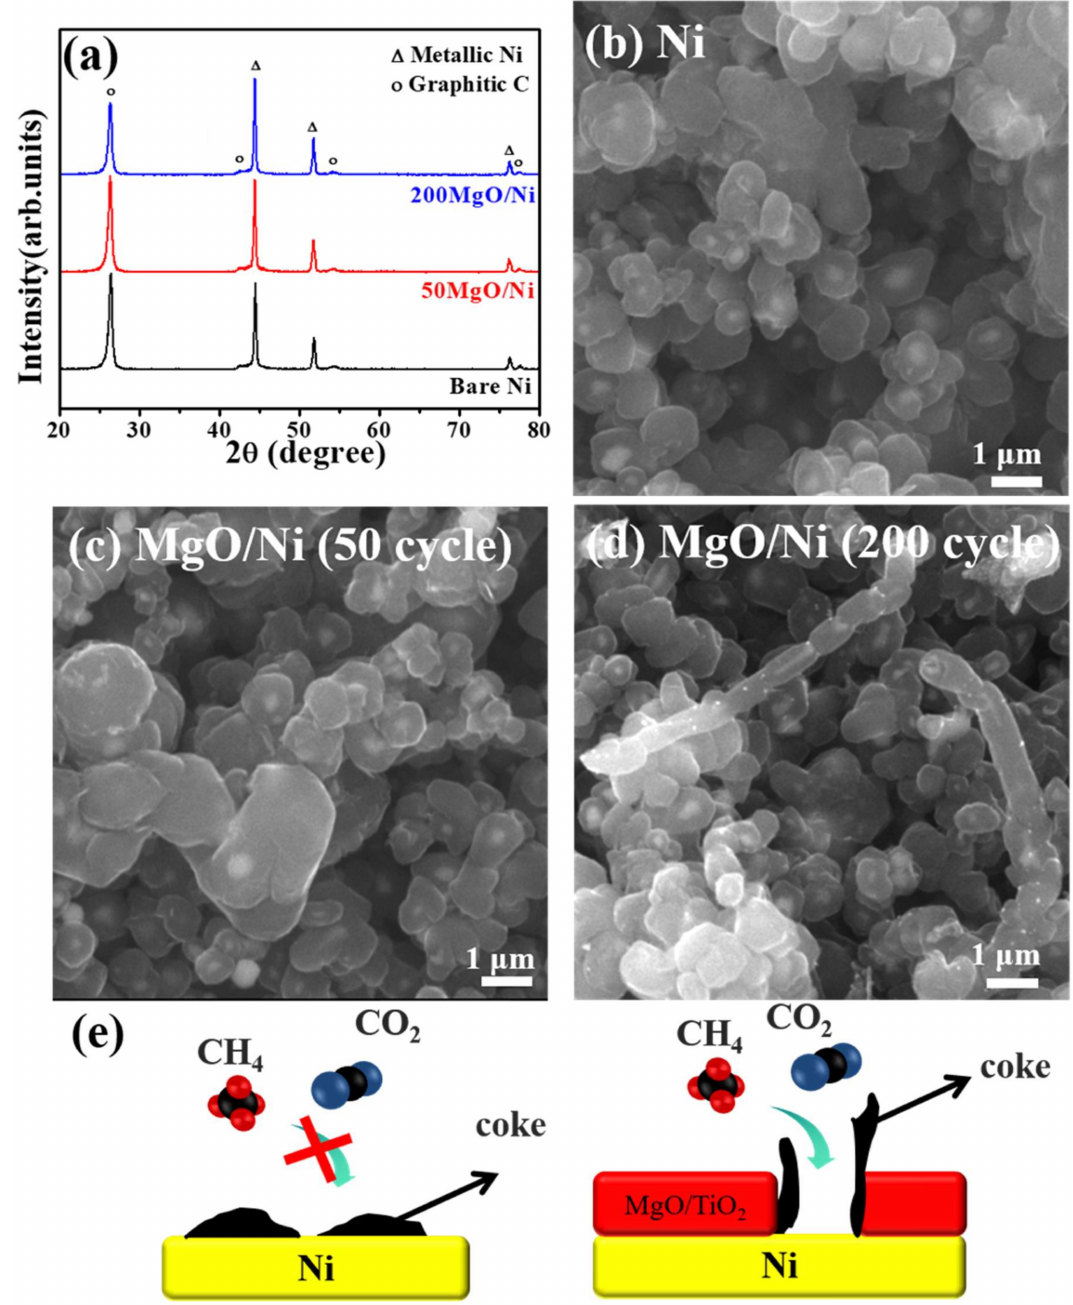
Figure 4. ( a ) X-ray diffraction (XRD) and ( b – d ) SEM results of bare and MgO-wrapped Ni particles after 72 h of the DRM reaction. ( e ) Schematic of the various deactivation behaviors. Edited from Reference